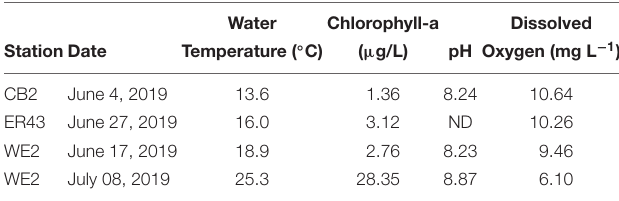
TABLE 2 | Ambient conditions at each sampling